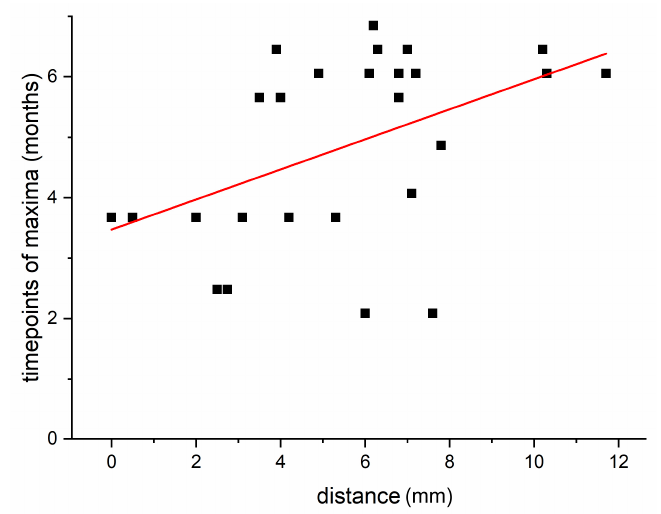
Figure 9. Graphic presentation of the time points of maximum mean optical density of all brain areas with their distance (mm) from the ipsilateral CPu. Plotted are the values for the temporal occurrence of the virtual maximum OD of the examined brain areas as well as the distance of their gravitational centers to that of the BoNT-A-injected CPu. There is a slight linear correlation (rank correlation coefficient according to Spearman = 0.45; p = 0.021) of the time point at which the maximum OD occurs (in the interpolated curves) and the distance from the injection site. The red line is the regression line calculated from the compared values.